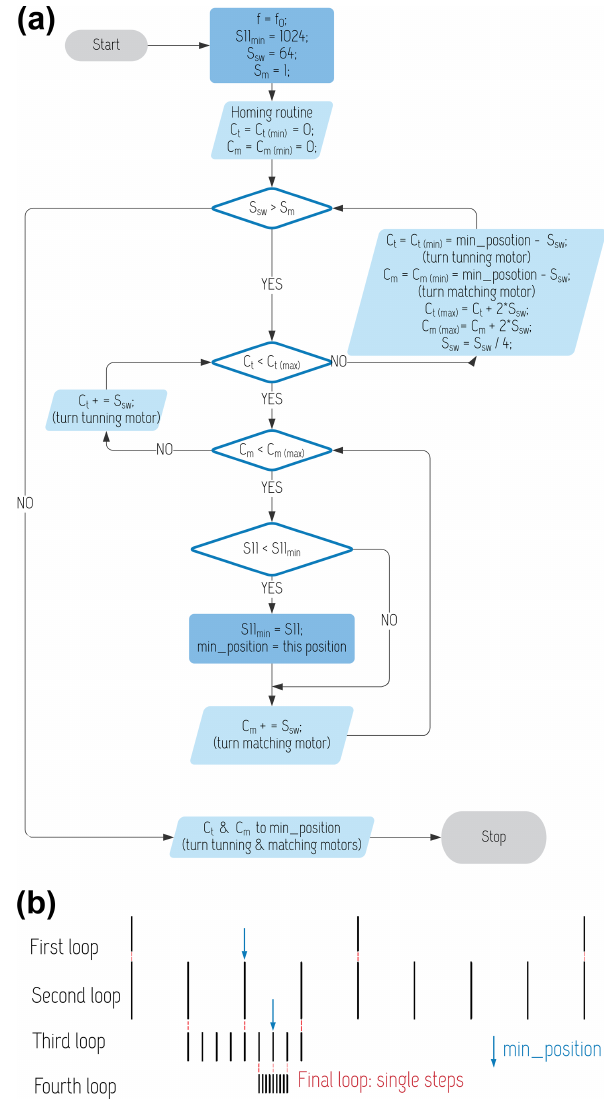
Figure 6. (a) T&M flowchart. (b) Schematic showing the interval subdivision method to zoom in on the S aa